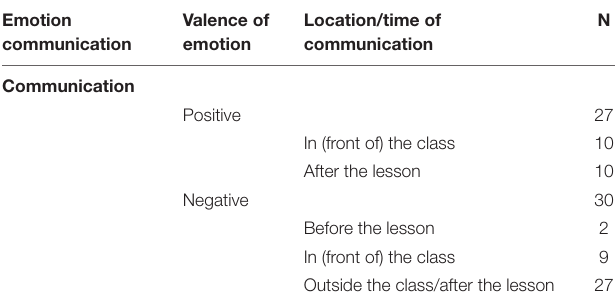
TABLE 3 | Emotion communication strategies and absolute number of team